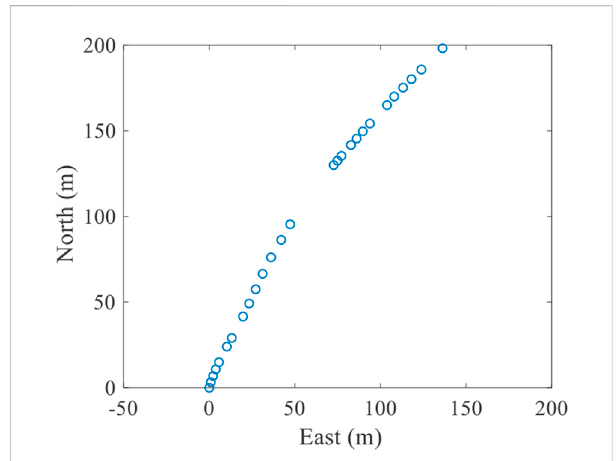
FIGURE 1 Position of the horizontal linear